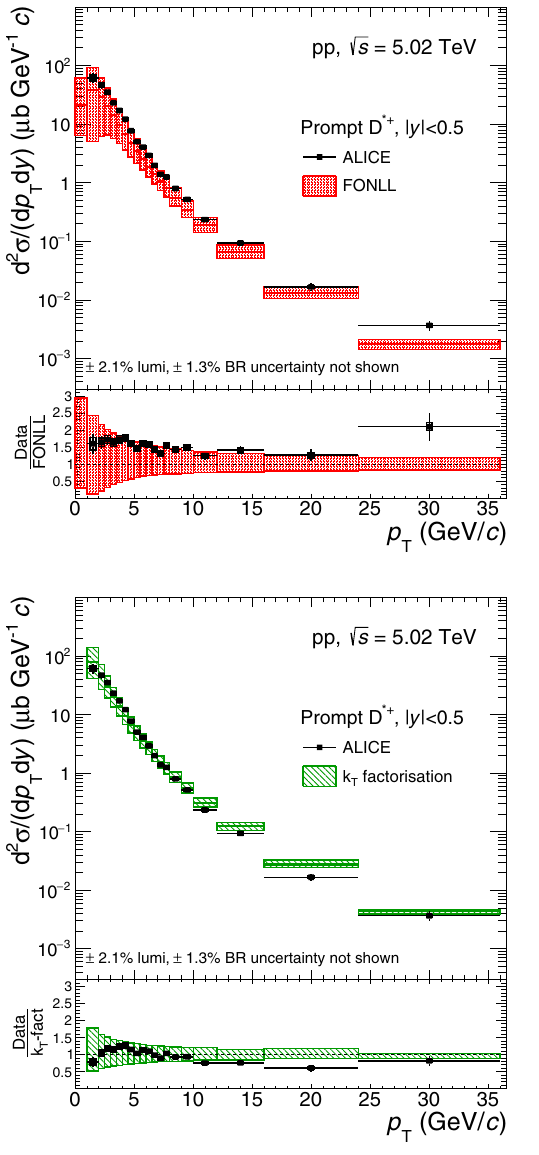
Fig. 10 p T -differential production cross sections for prompt D ∗+ meson compared to pQCD calculations: FONLL [7,8], GM- VFNS(mod- μ R , F ) [39,40], GM-VFNS(SACOT- m T ) [6], and k T -